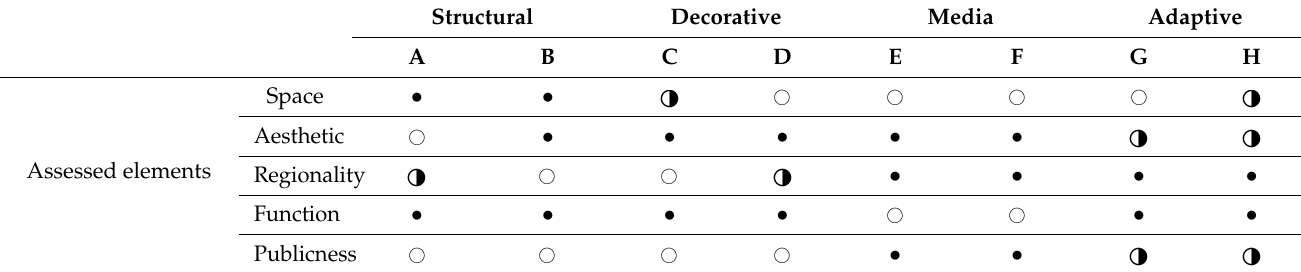
Table 10. Trends of expression for each assessed element. Key: Excellent • , Good